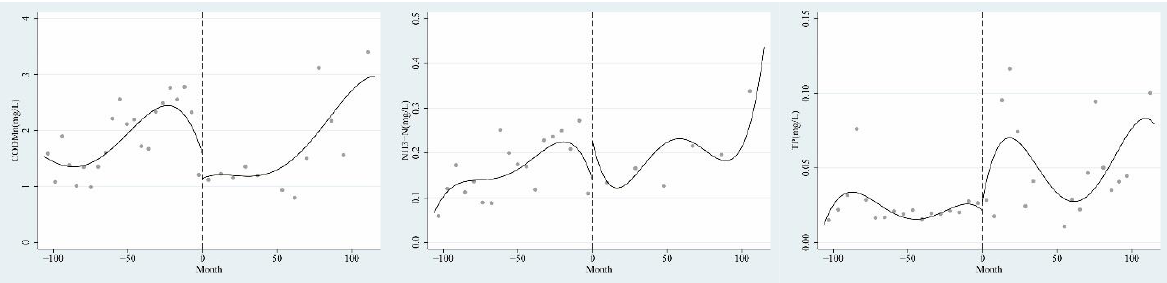
Figure 5. Regression discontinuity analysis on the discontinuity point. Note: the points are the monitoring data, and the lines are modeled using regression discontinuity.